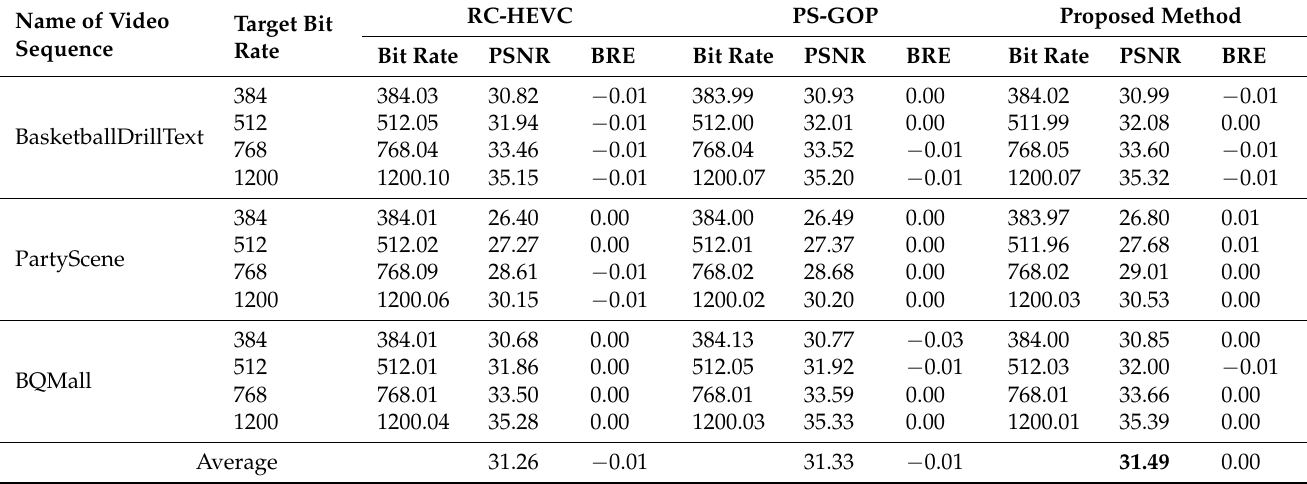
Table 3. The Performance of PSNR and BRE of Video Sequence with Resolution of 832 ×